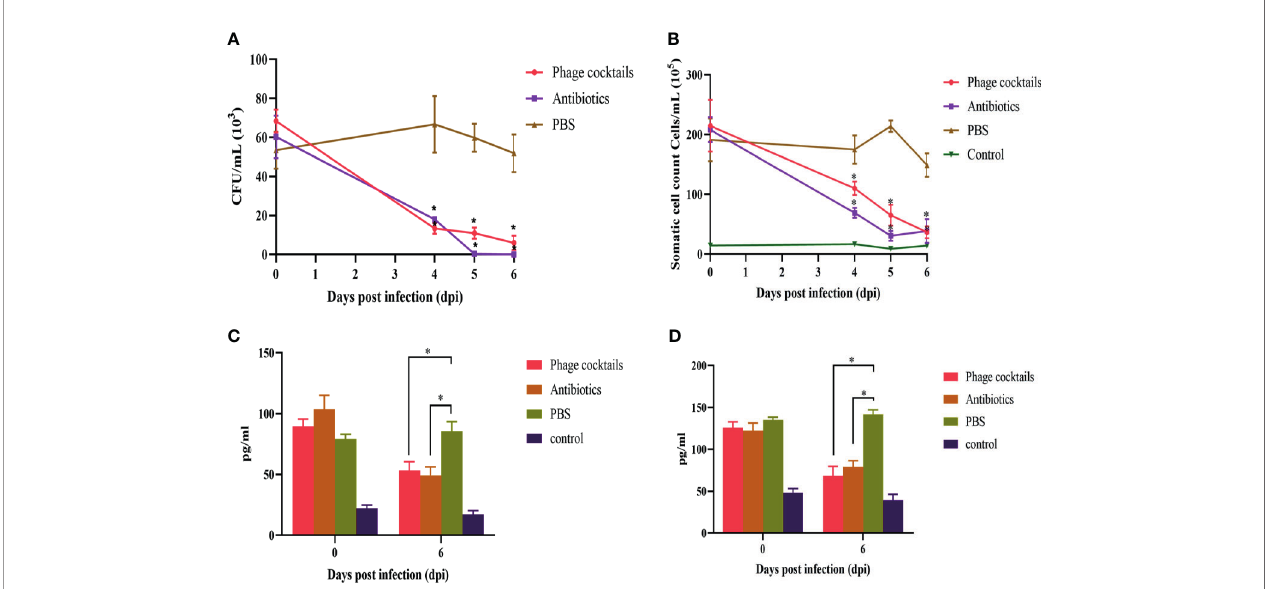
FIGURE 5 | Antibacterial ef fi cacy of phage cocktails against mastitis induced by E.coli . Cows challenged by E.coli -induced mastitis were intramammarily infused with phage cocktails containing vB_EcoM_SYGD1, vB_EcoP_SYGE1, and vB_EcoM_SYGMH1, and the bacteria load (A) and SCC (B) of milk samples were detected after three-day treatment, every 24 h. Concentrations of IL-1 b (C) and TNF- a (D) in the sera of cows before treatment (0 day) and on the sixth day after beginning of treatment were measured using indirect ELISA. Data were analyzed using GraphPad Prism v 8.0 software. *Indicate signi fi cant differences between phage cocktails or antibiotics and untreated groups, as calculated by t -tests ( p <